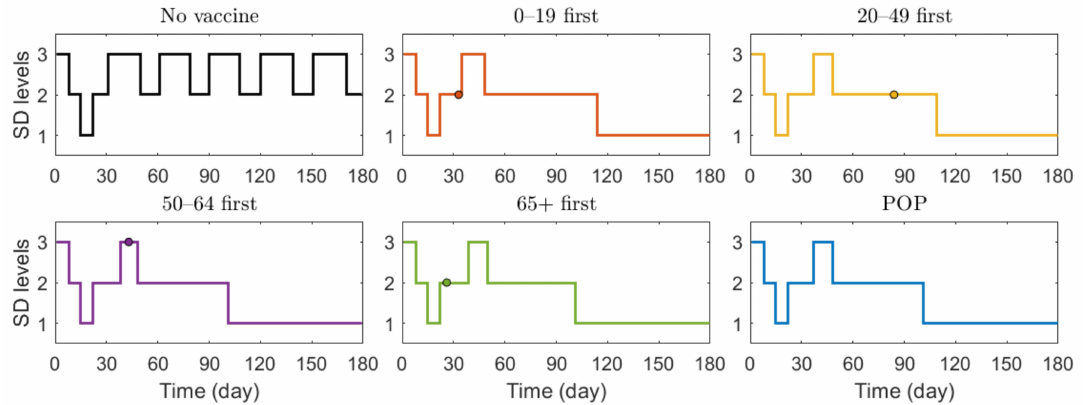
Figure 6. Transition of SD level according to the incidence under different scenarios.